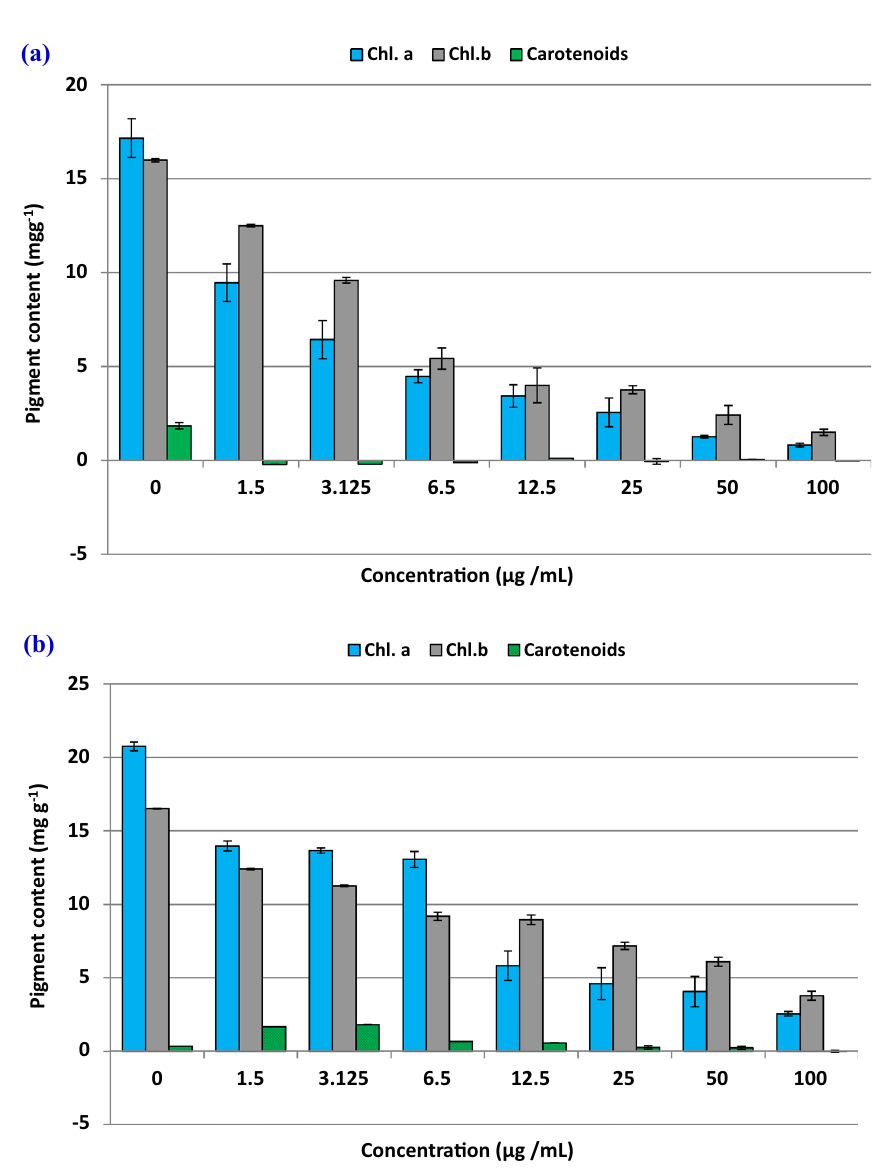
Figure 10. Decrease of photosynthetic pigments content (Chl. a ,Chl.b and carotenoids) in Chlorella vulgaris ( a ) and Chlorella minutissima ( b ) micro green algae exposed to gelatin-capped silver nanoparticles for 96 h.The experiments were performed in triplicate and results are represented as the mean with standard